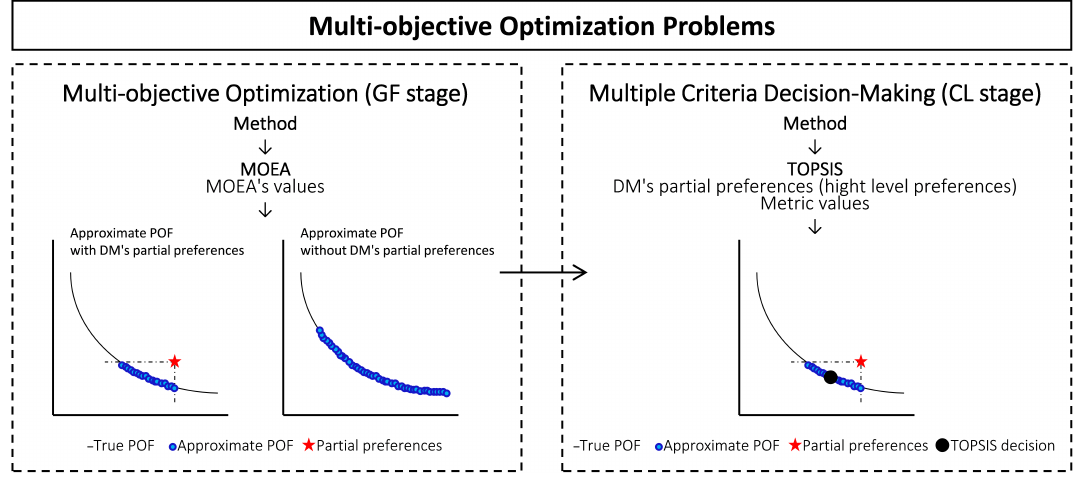
Figure 2. Proposed two-stage MOO and MCDM